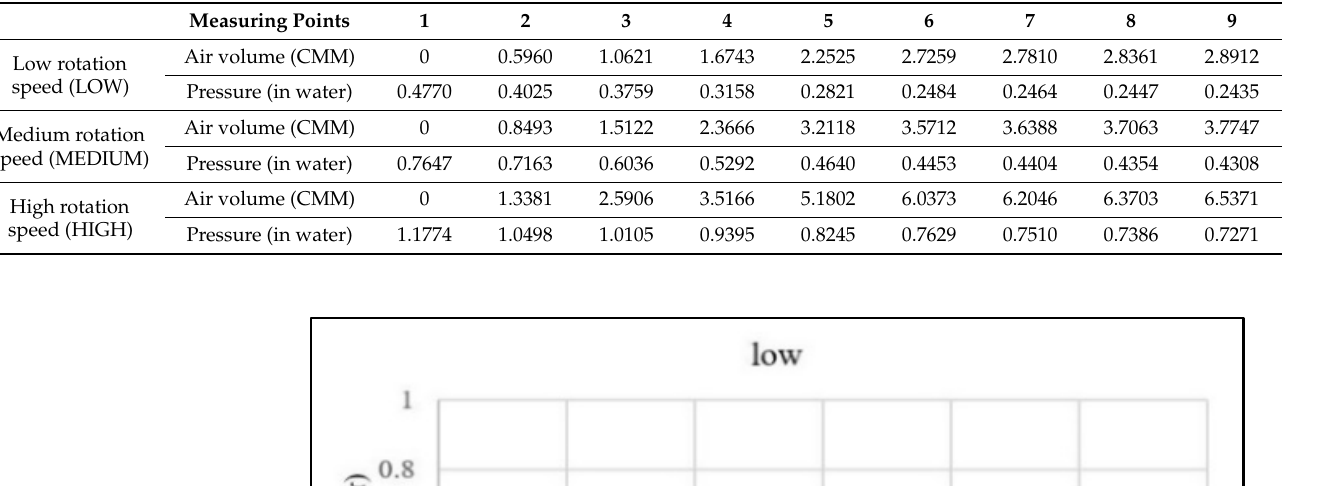
Table 1. Pressure and air volume of the air purifier at different rotation speeds.